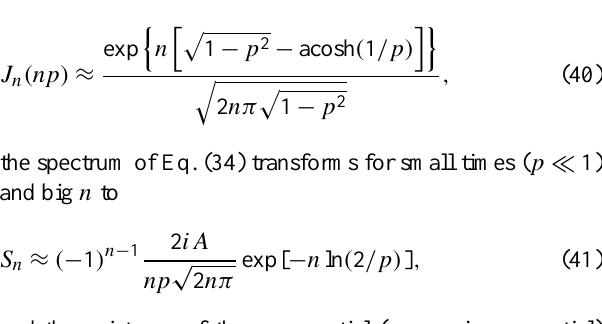
Figure 10. Spectrum of a Riemann wave with CQ = 1 at breaking time against breaking power asymptotic